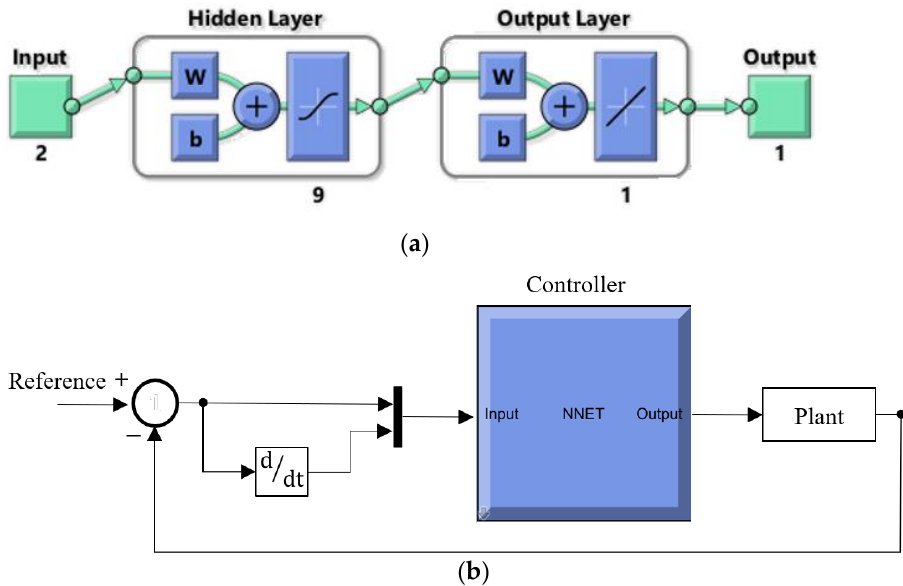
Figure 7. Artificial Neural Network architecture. ( a ) Diagram of ANN controller; 2 inputs and 1